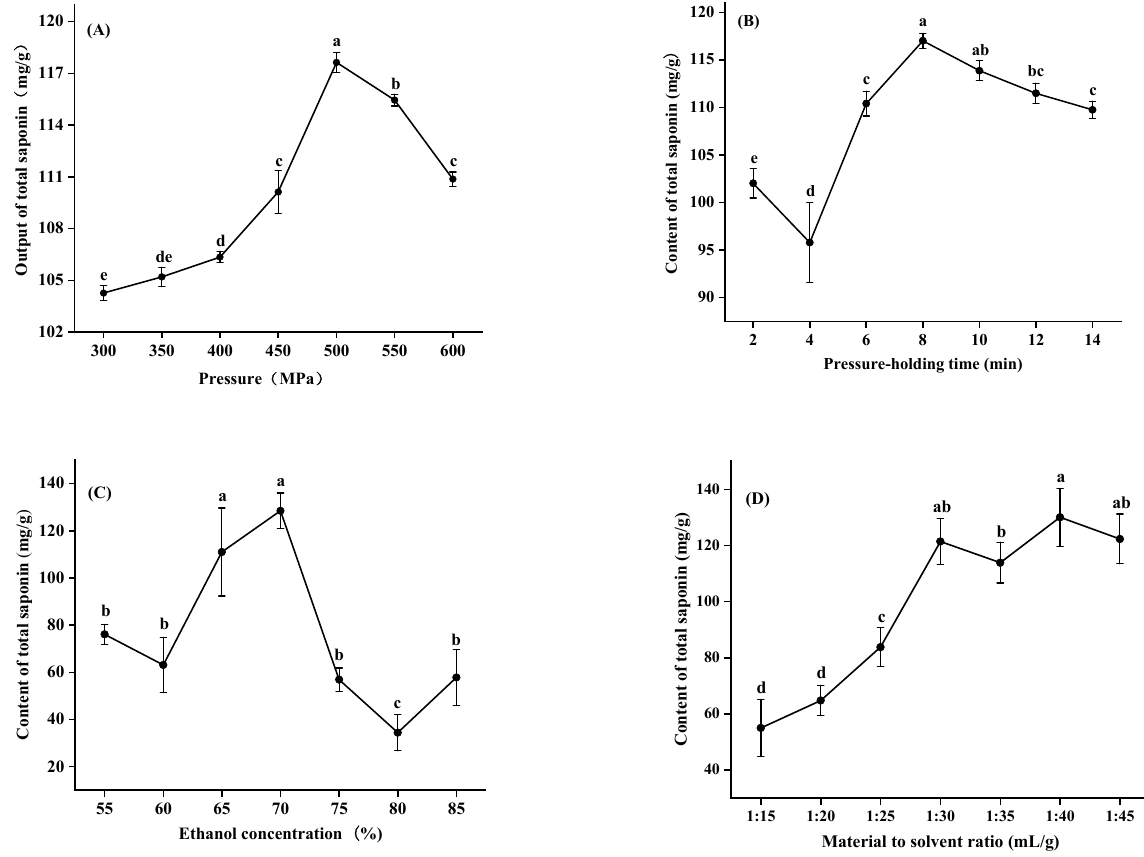
Figure 2. Effect of pressure ( A ), pressure-holding time ( B ), ethanol concentration ( C ) and material to solvent ratio ( D ) on the output of total saponins for HHP extraction. Values are means of triplicate ± standard deviation. Different letters represent significant differences ( p < 0.05).